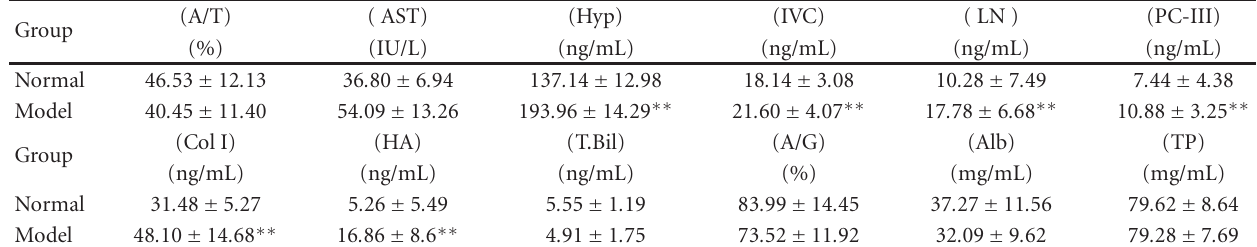
Table 3: The content of determined parameters in the serum during TAA induction ( x ± s ). Group